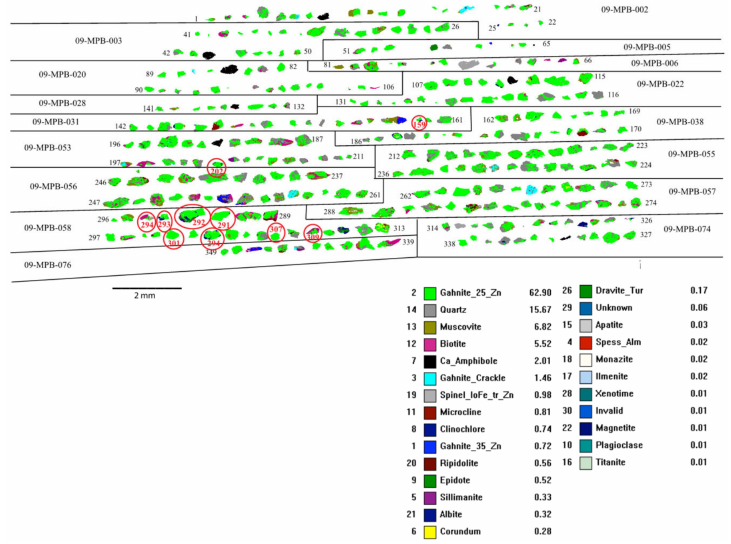
Figure 6. MLA-SEM image of gahnite grain mount 10-0269-P01 for Izok Lake samples. Adhering gangue mineral compositions are indicated with various colours outlined in the legend. Till sample numbers are listed on the outer sides of the image and grain position numbers on the mount are listed at the end of each row. Red circles indicate those grains for which the LA-ICP-MS/EPMA mineral chemistry is anomalous (Hicken, 2012 [165]).